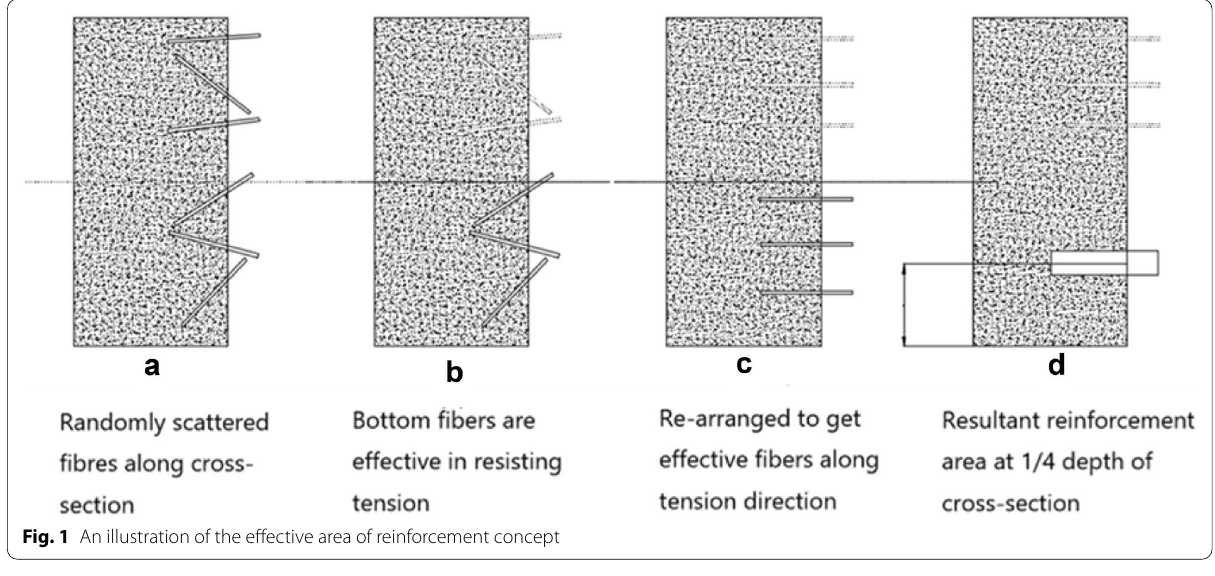
Fig. 1 An illustration of the effective area of reinforcement